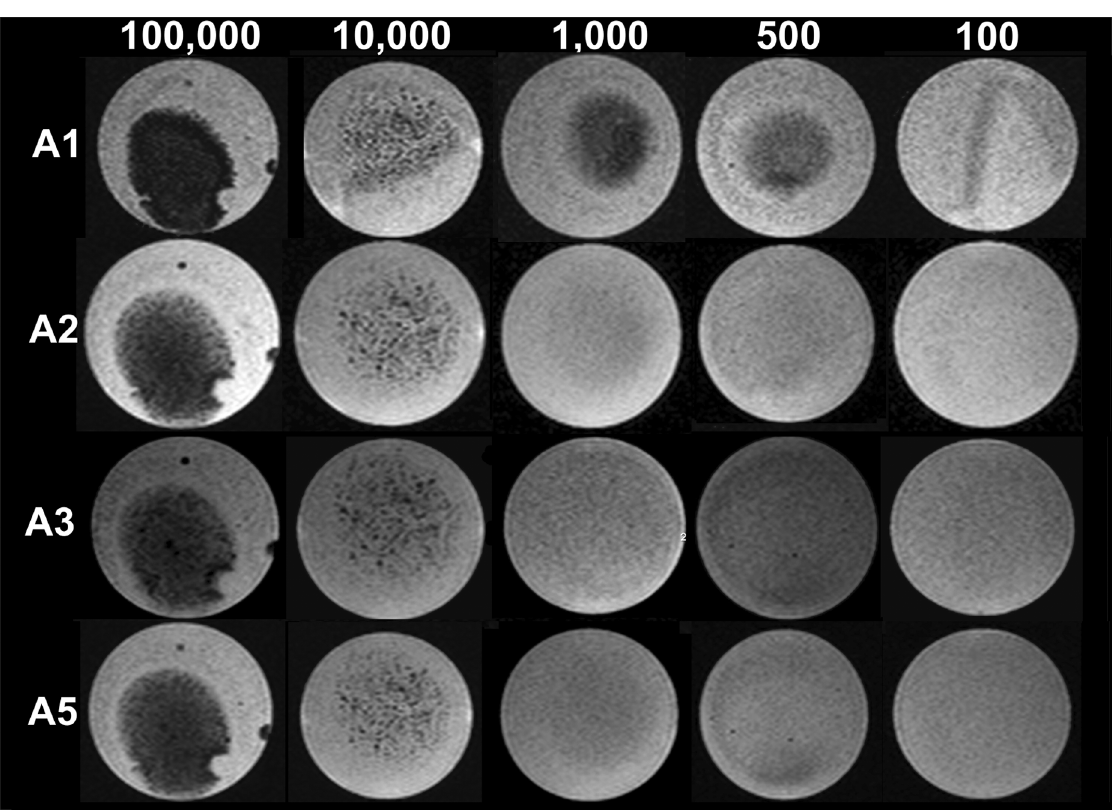
Figure 4. Representative phantom MR images for evaluation of the detection limit, images of Group A. Cross sectional images of results from group A at different cell concentrations and with different pulse sequences. The cell concentrations are indicated in the top row, the pulse sequences are indicated on the left according to Table 1. In sequence A1, the sequence with the highest sensitivity, a clear signal loss can bee seen at cell concentrations of 500, whereas the other sequences do not show any signal loss at this concentration. There is also some signal loss at 100 cells. Between the T2* sequence (A5) and a SWI sequence at the same voxel size (A2) no obvious difference can be seen, although the T2* weighted sequence was rated slightly more sensitive than the SWI